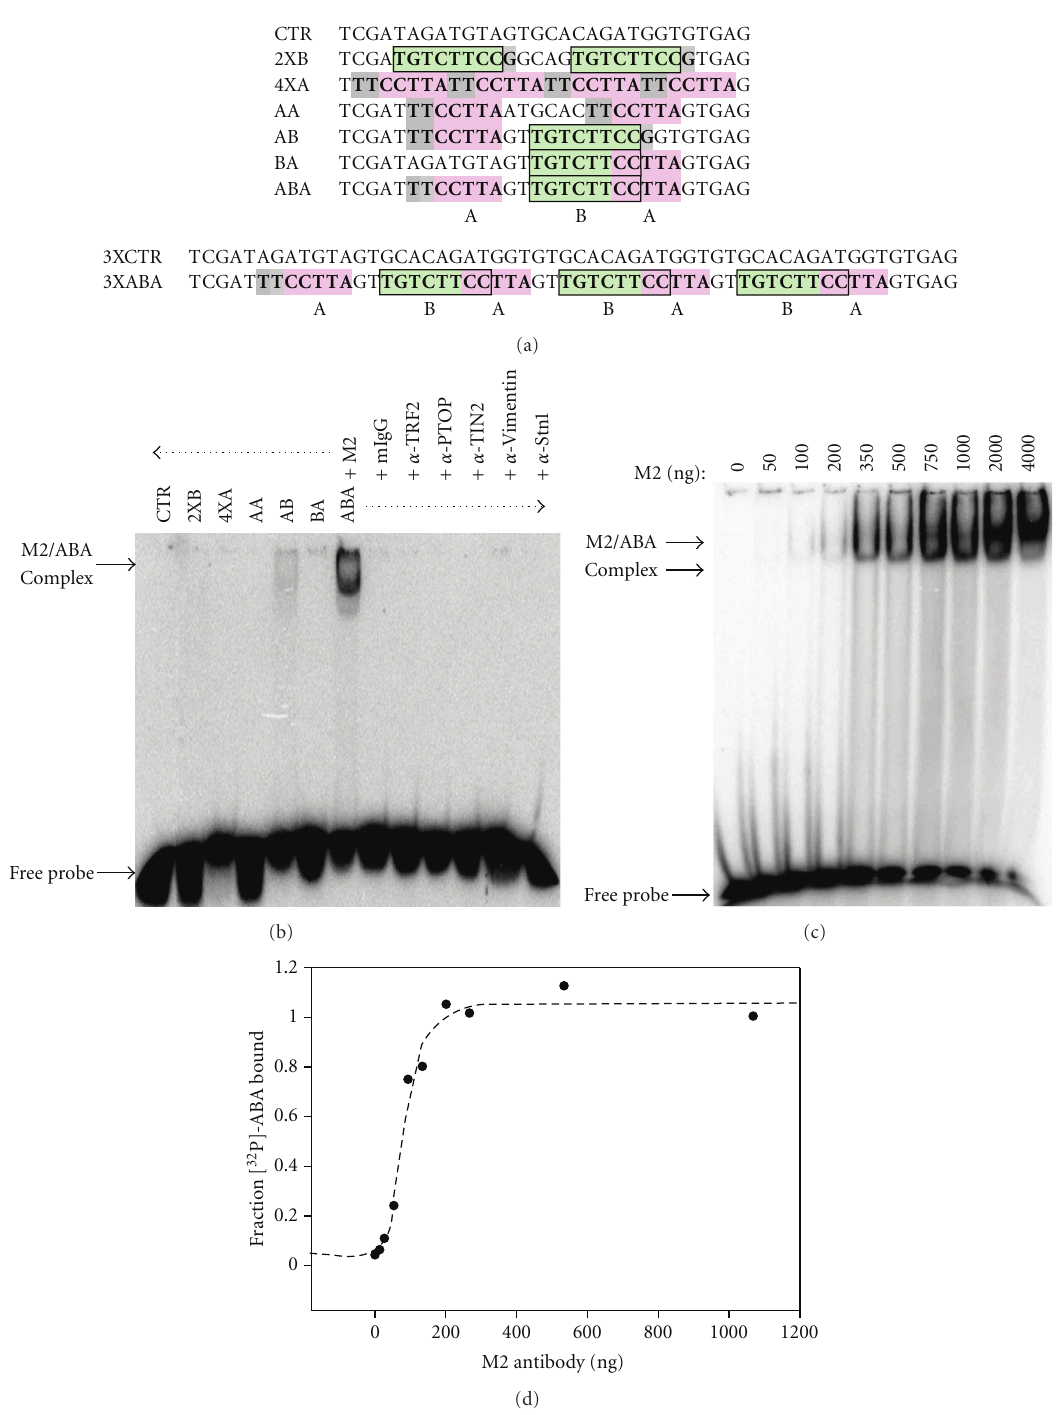
Figure 2: The bipartite ssDNA consensus binds directly to the anti-Flag M2 antibody. (a) Sequence and graphical representation of the probes used. All probes were labeled at the 5 (cid:2) -end with [ 32 P]. Probes were designed to carry none, one, or both of the identified motifs. Motif A = CCTTA (pink). Motif B = TGTCTWCC (green). (b) The anti-Flag M2 antibody binds selectively to probe ABA. The indicated probes (80,000cpm) were incubated with the listed antibodies (1 μ g), after which protein/DNA complexes were resolved by electrophoresis in a native polyacrylamide gel. (c) Titrationof the M2 antibody. A constantamountof probe ABA wasincubated withan increasing concentration of M2 antibody, and the protein/DNA complexes were resolved by native electrophoresis. At the higher antibody concentrations, a larger protein/DNA complex is observed (top arrow), which may represent the product of antibody oligomerization.(d) Binding isotherm of probe ABA interacting with the anti-Flag M2 antibody. The scatter plot shows the amount of ABA bound (amount present in both protein/DNA complexes) as a function of antibody concentration. Dotted line shows fitting of the data to a “one site” saturation binding curve. Nonlinear regression of the data allowed for the determination of the dissociation constant ( K D = 80 ± 7nM). Error on the value of the K D represents the 95% confidence interval of the best-fit